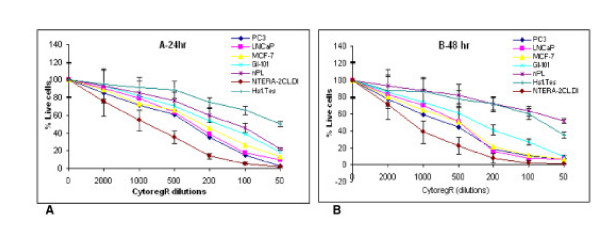
Growth inhibition of human adenocarcinoma cells. Cells were grown and treated with indicated concentrations of cytoregR as described in the methods. Cell growth inhibition (cell death) was assessed by passage of Trypan blue dye into the cells, observed under microscope. The percentage of the live cells was determined by as described in the methods. A-24 hr: Percentage of live cells after 24 hr treatment. B-48 hr: The percentage of live cells at 48 hr treatment. The values represent the means +SEM of triplicates from two independent experiments. Bars = SEM